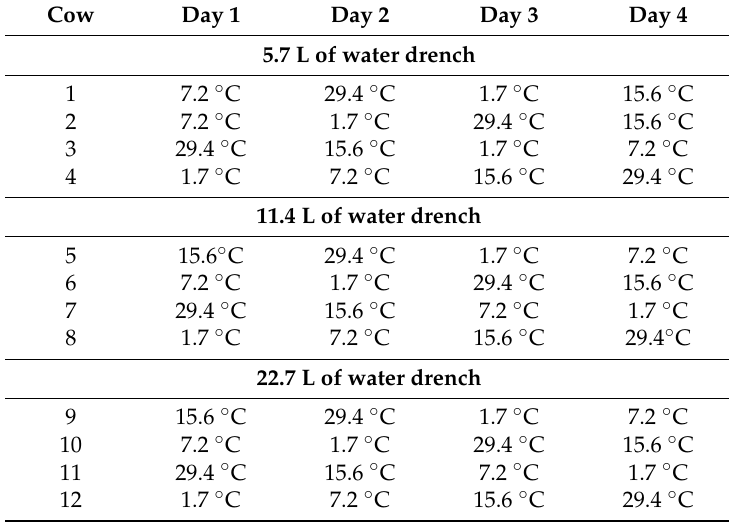
Table 1. Modified Latin Square experimental treatment assignments (experiment part 2) for feed restricted, pregnant, mid-lactation cows ( n = 12) receiving the same water quantity drench on each day at a different experimental water